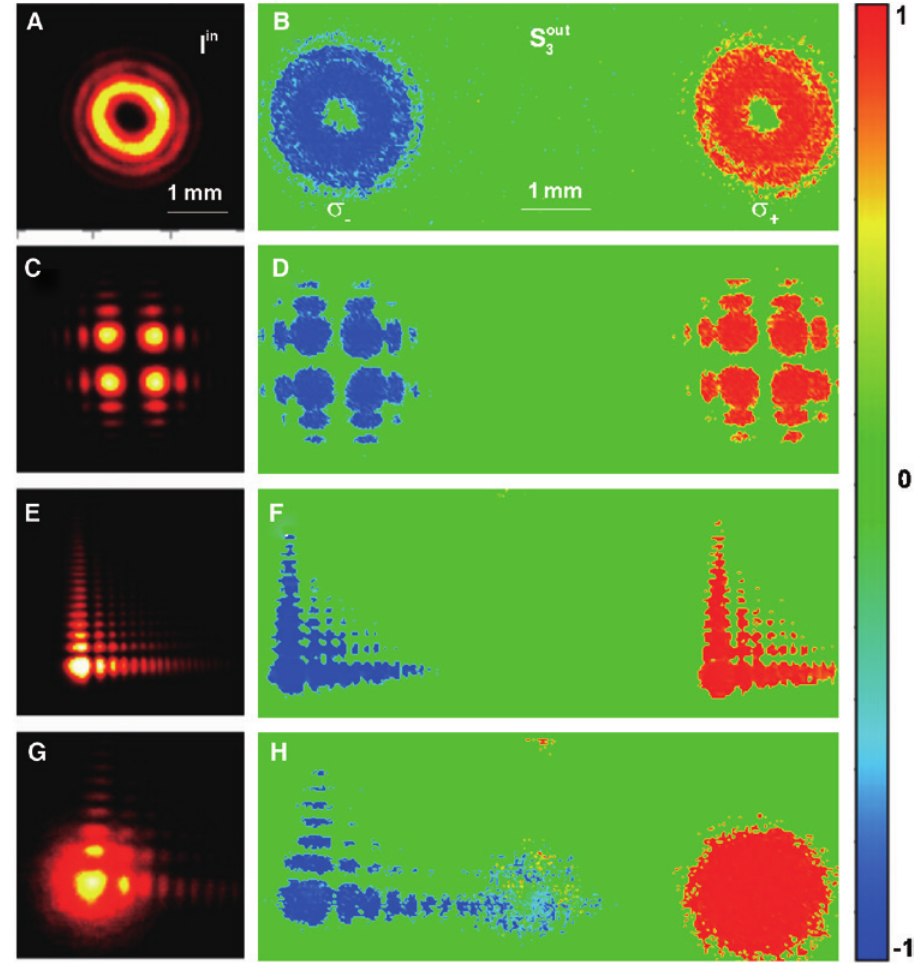
Figure 13: Left column shows the intensity patterns of three typical linear polarization beams (vortex beam, Hermite-Gaussian beam, and Airy beam in the order from top to bottom) and the superposition of a right-handed circular polarization plane Gauss beam and a left-handed circular polarization Airy beam. Right column is the corresponding normalized Stokes parameter S splitter. Blue color represents the right polarization and red for left polarization. Adapted from Ref.